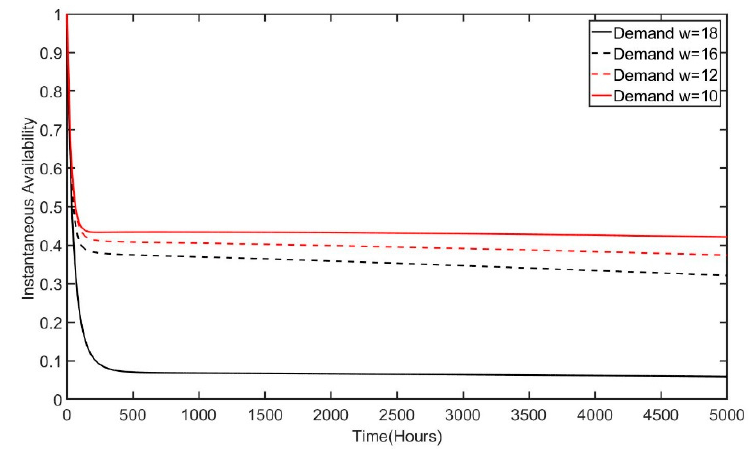
Figure 8. Instantaneous availability the FMS under different demands.